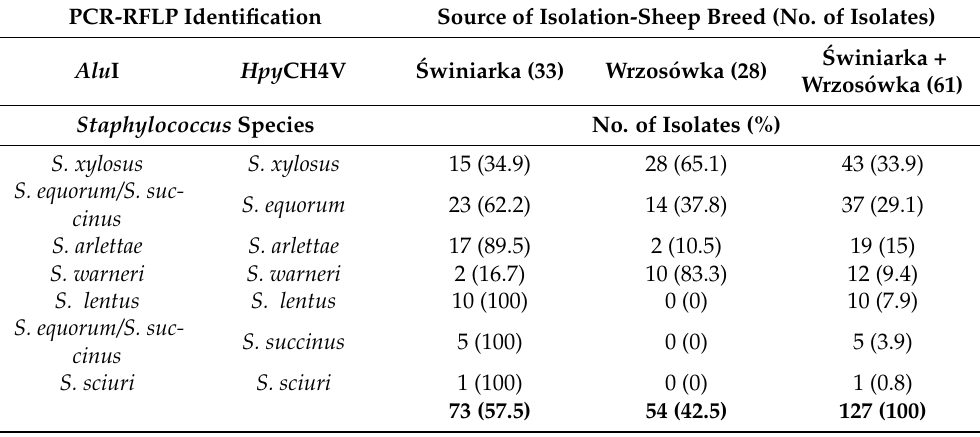
Table 1. Identification of staphylococci isolated from ´Swiniarka and Wrzos ó wka